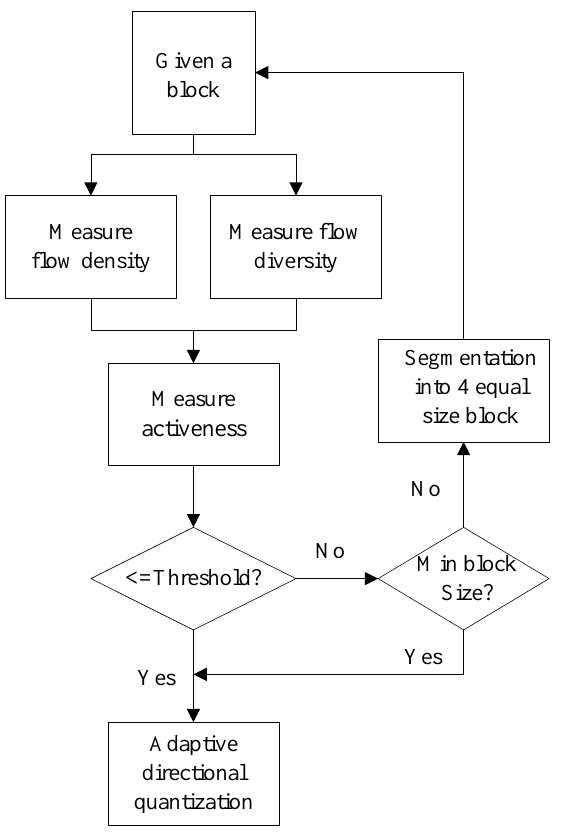
Figure 3. Algorithm of the adaptive multi-scale quantization.